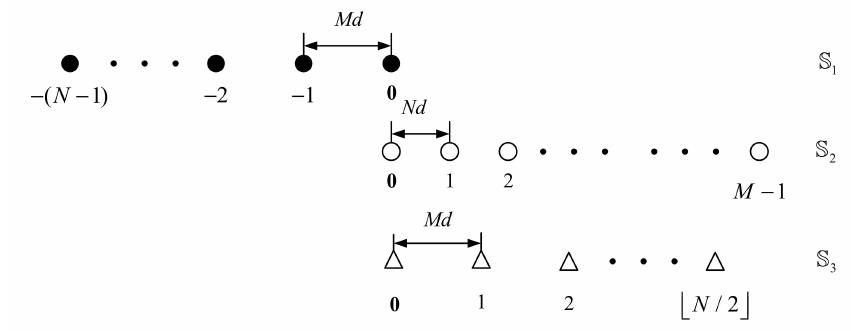
Figure 1. Unfolded coprime linear array with three subarrays (UCLATS).